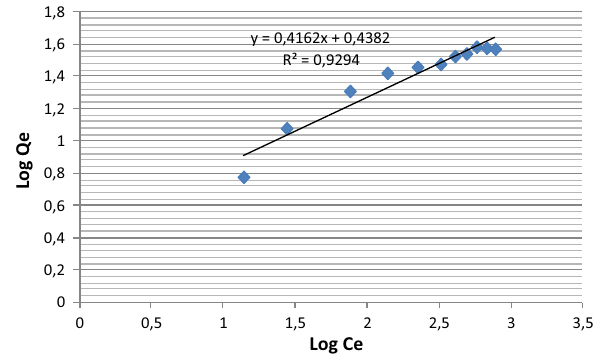
Fig. 3 Freundlich adsorption isotherm